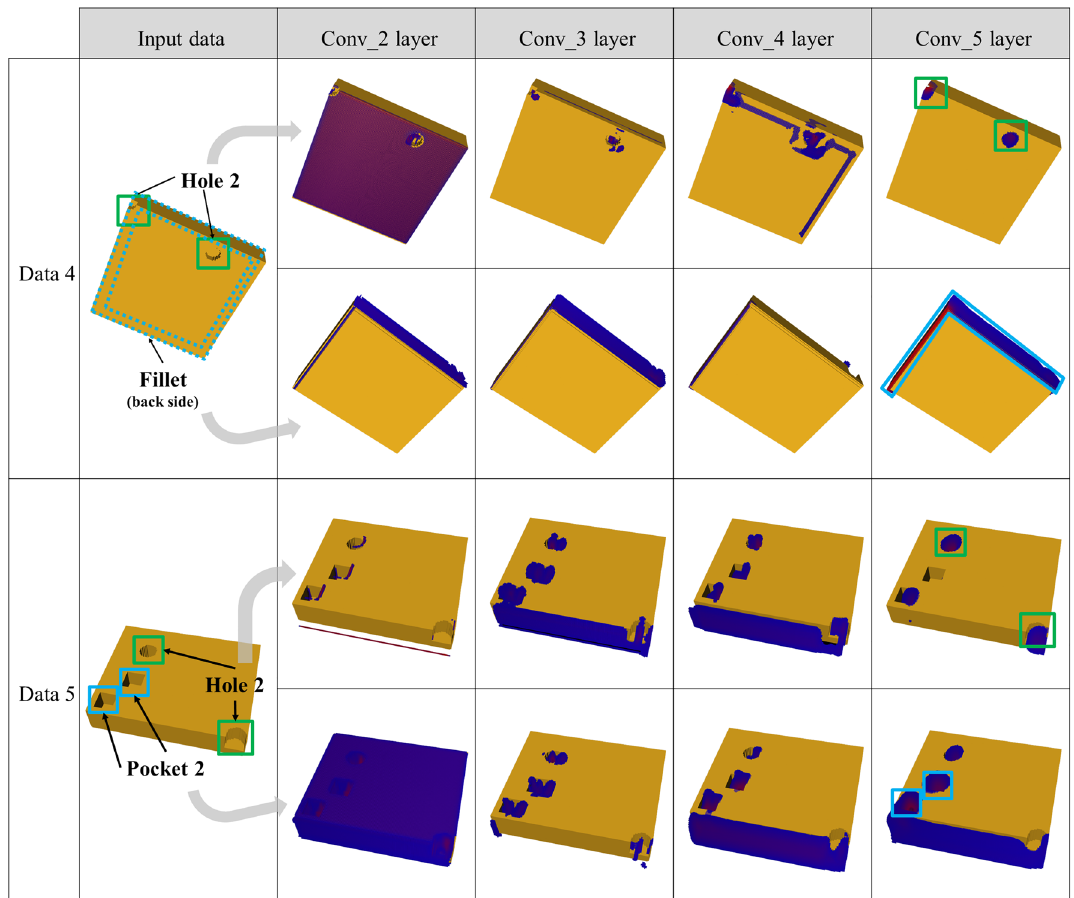
Figure 8. Visual explanation of the machining feature area using Grad-CAM for voxel size 128 × 128 ×